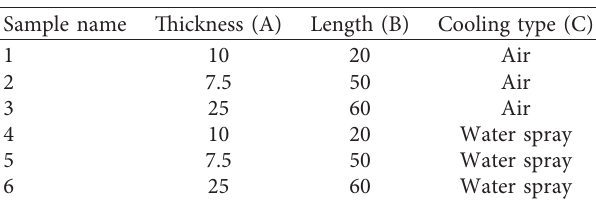
Figure 2: Regional schematic representation of the extrusion piece. Table 2: Labeling of samples.